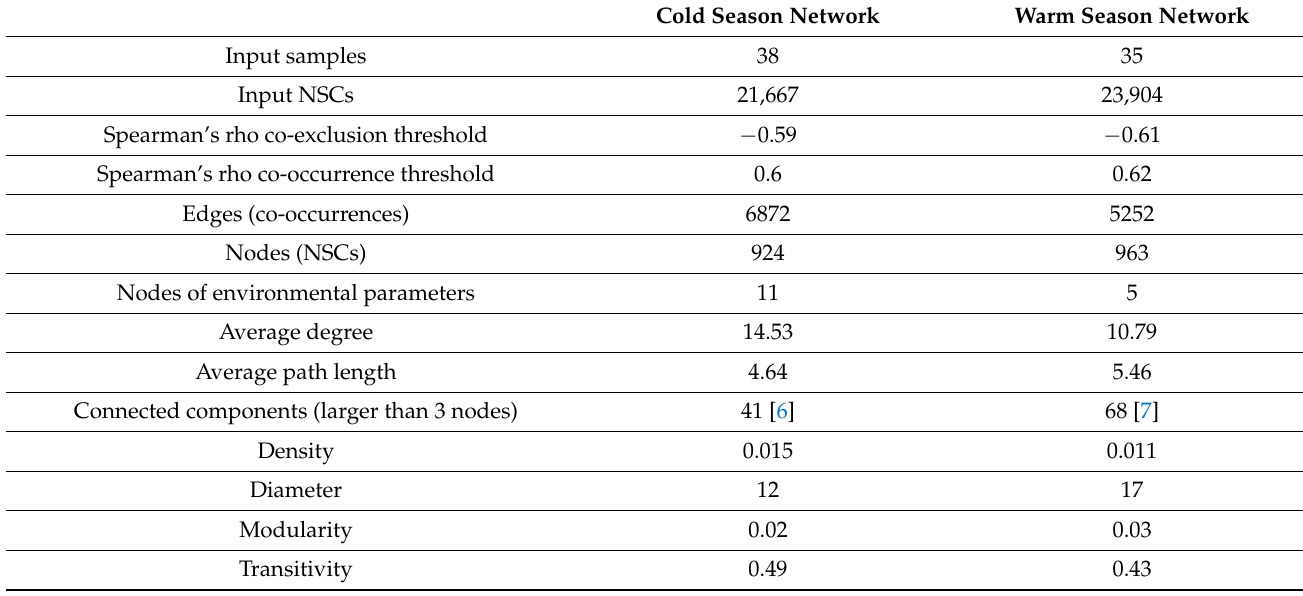
Table 2. Key properties of the co-occurrence networks in both seasons.